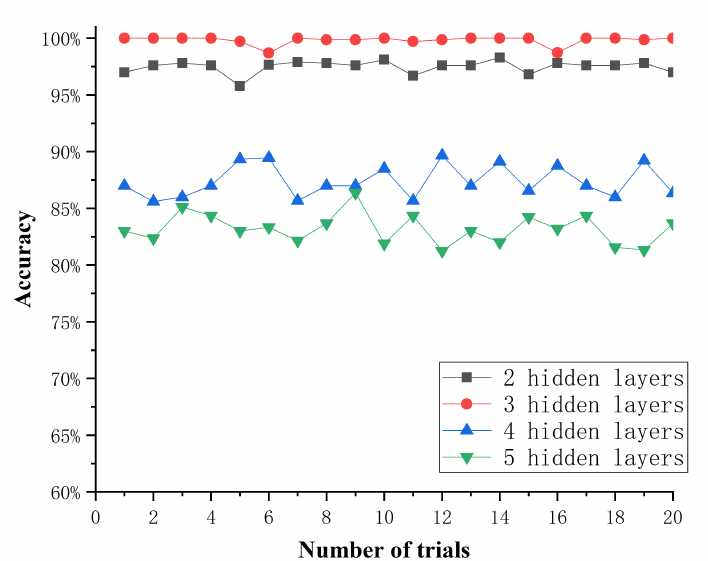
Figure 9. Accuracy of 20 simulation experiments.